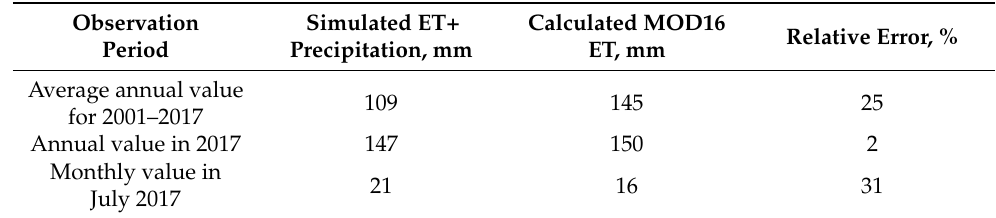
Table 3. Comparison between the simulated evapotranspiration (ET) values plus precipitation and those calculated using observational data.